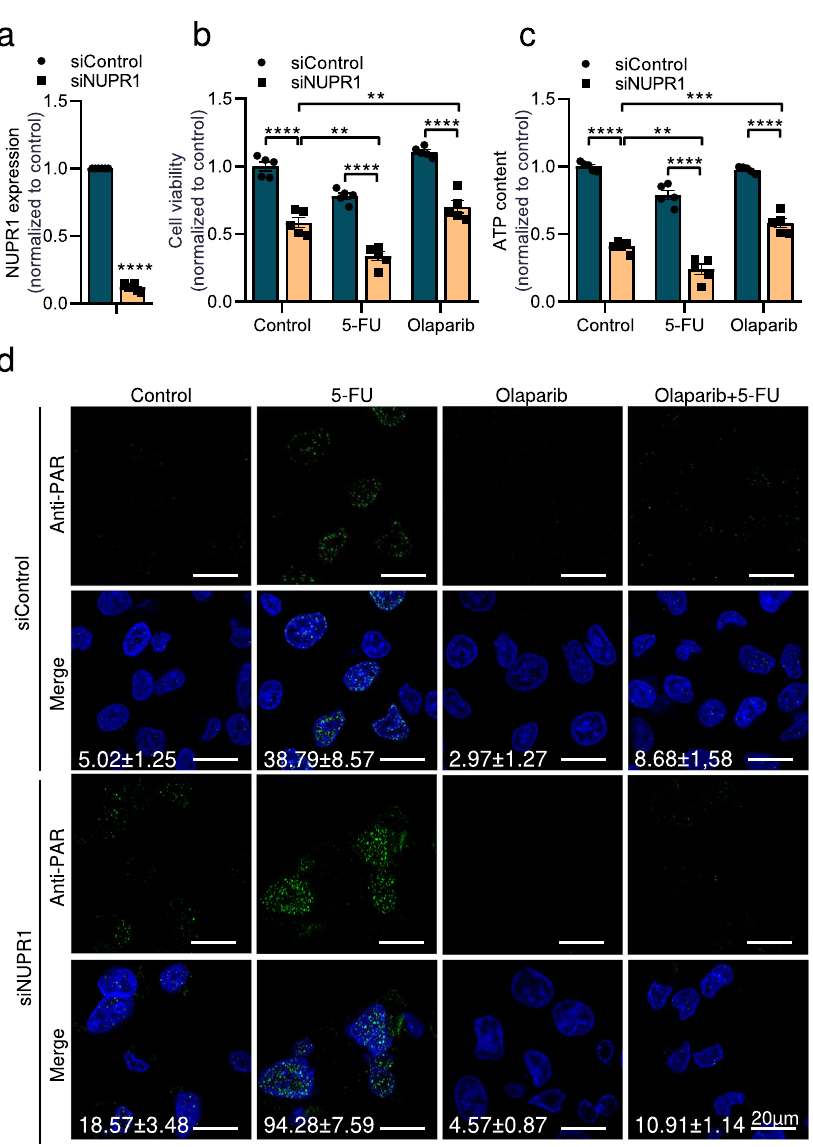
Fig. 6 Olaparib prevented cell death and ATP level decrease in NUPR1-depleted cells. MiaPaCa-2 cells were transfected with siControl or siNupr1 for 48 h. a Total RNA was extracted to monitor the mRNA level of NUPR1 by RT-qPCR 48 h post-transfection. Cells were treated with 5-FU or olaparib for 24 h. b Cell viability and ( c ) ATP levels were measured. Data represent mean ± SEM. Two-way, Sidak was used, * P < 0.05; ** P < 0.01; *** P < 0.001; **** P < 0.001. d Immuno fl uorescence with a mouse anti-PAR and Alexa 488-labeled goat anti-mouse secondary antibodies were used. A representative experiment is shown ( n =